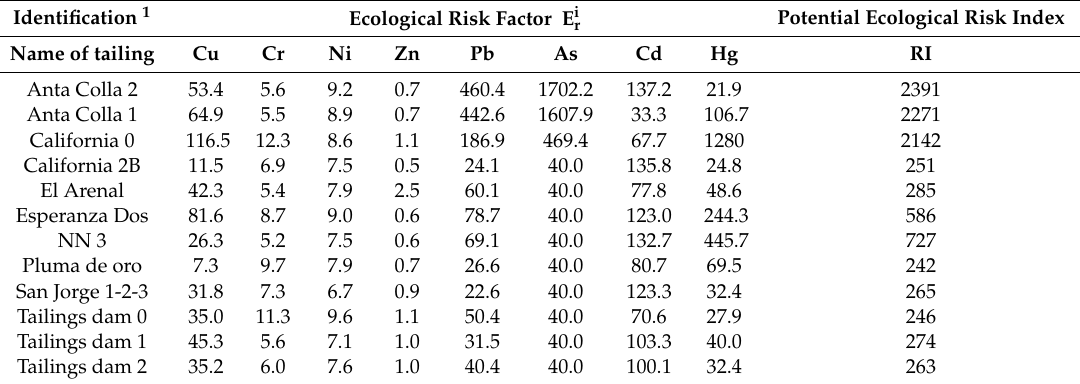
Table 7. Average heavy metal concentration values and potential ecological risk index for Illapel critical tailings.